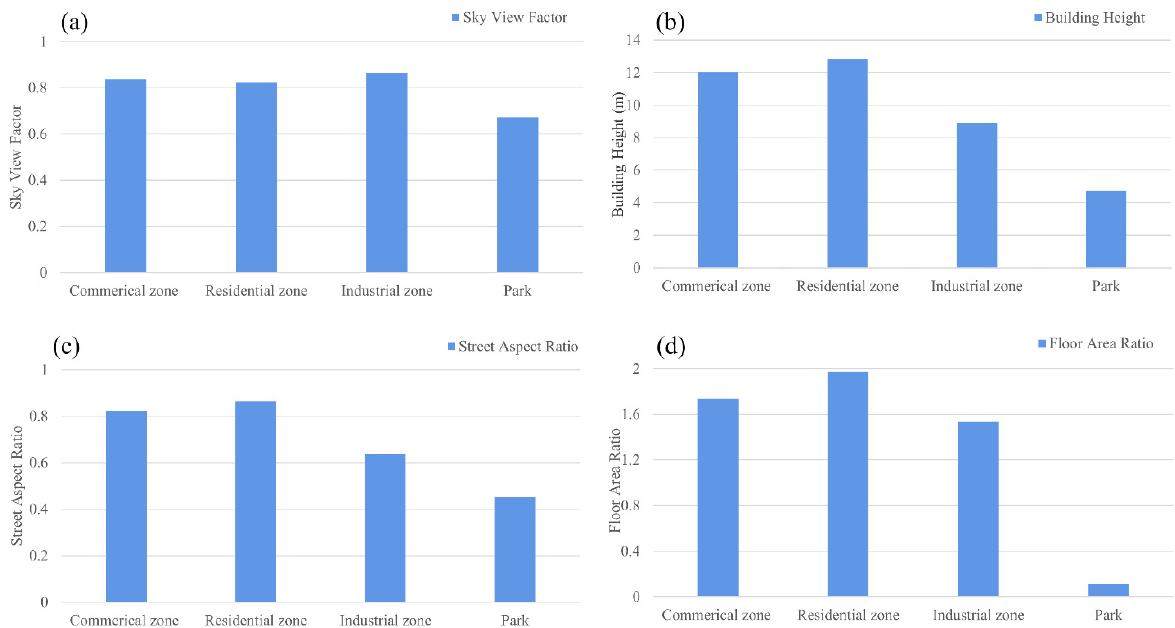
Figure 1. An investigation of 3D USPs across different functional zones in the northern part of Brooklyn, New York City, USA. ( a ) Sky view factor (SVF), the visible degree of sky in the ground level, ( b ) building height (BH), the height of building, ( c ) street aspect ratio (SAR), the ratio of average building height to street width, and ( d ) floor area ratio (FAR), the ratio of total building floor area to block area.